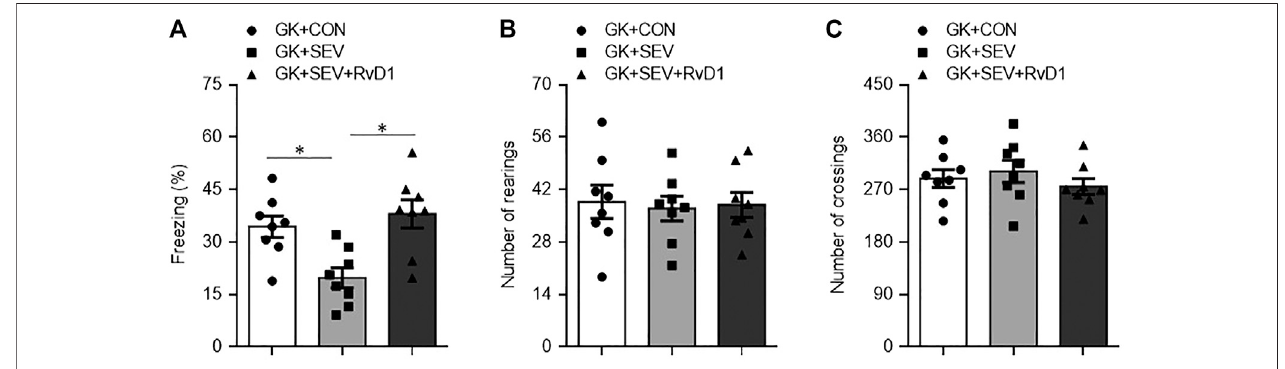
FIGURE 5 | Freezing times infear conditioning task (A) and number ofrearings (B) and crossings (C) inopen- fi eld testintype 2 diabetic Goto-Kakizaki (GK)ratsafter control(CON)orsevo fl urane(SEV)exposureandinexogenousRvD1-treatedGKratsafterSEVexposure.Dataarepresentedasmean ± SE(n (cid:1) 8foreachgroup).* p < 0.05.